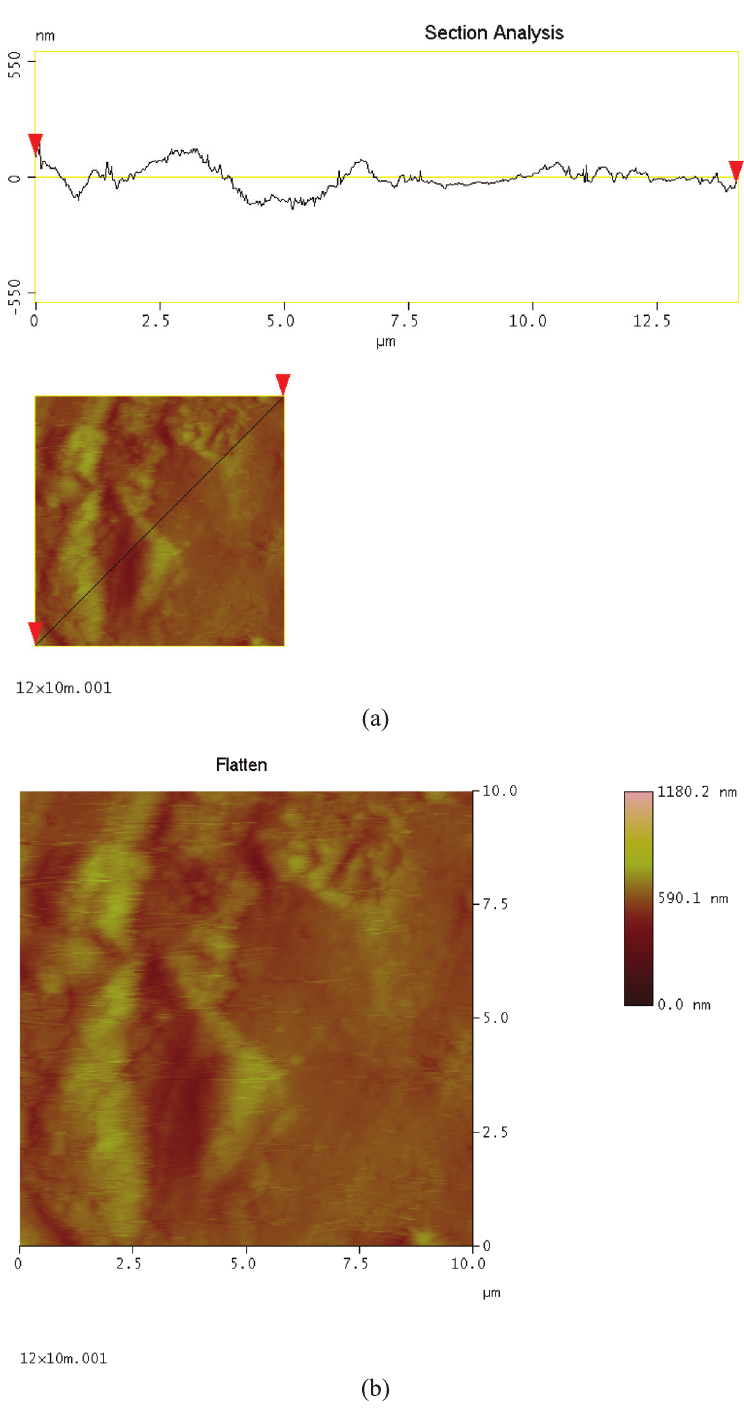
Fig. 1: AFM photographs of the ECTW; a) section and b) flatten